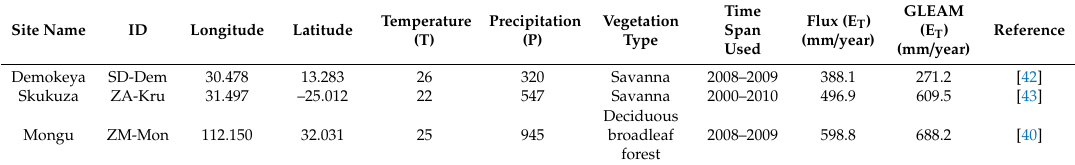
Table 1. Site names and available number of years of the study sites used for evapotranspiration (ET)